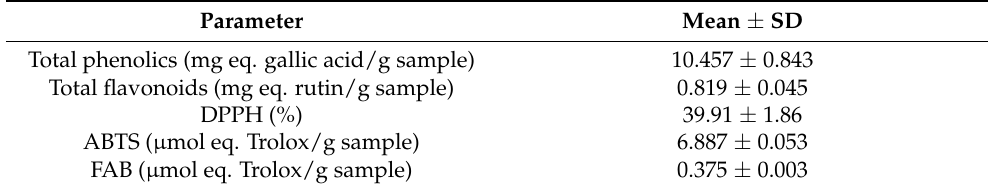
Table 2. Experimental determinations of the total phenolic and flavonoid contents in the L. chinensis extract and the results from the antioxidant capacity assays (ABTS, DPPH, and FRAP). Parameter